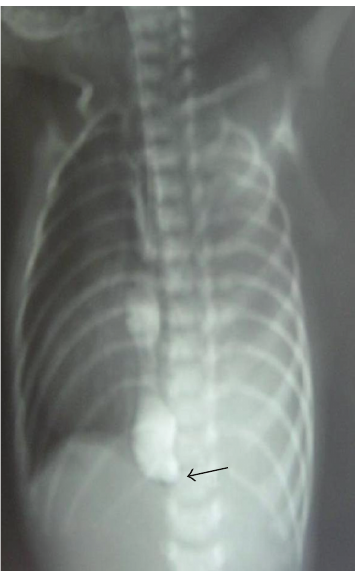
Figure 1: Contrast esophagogram showing holding up (arrow) of contrast at the level of the diaphragm with evidence of CDH with lower esophageal obstruction.